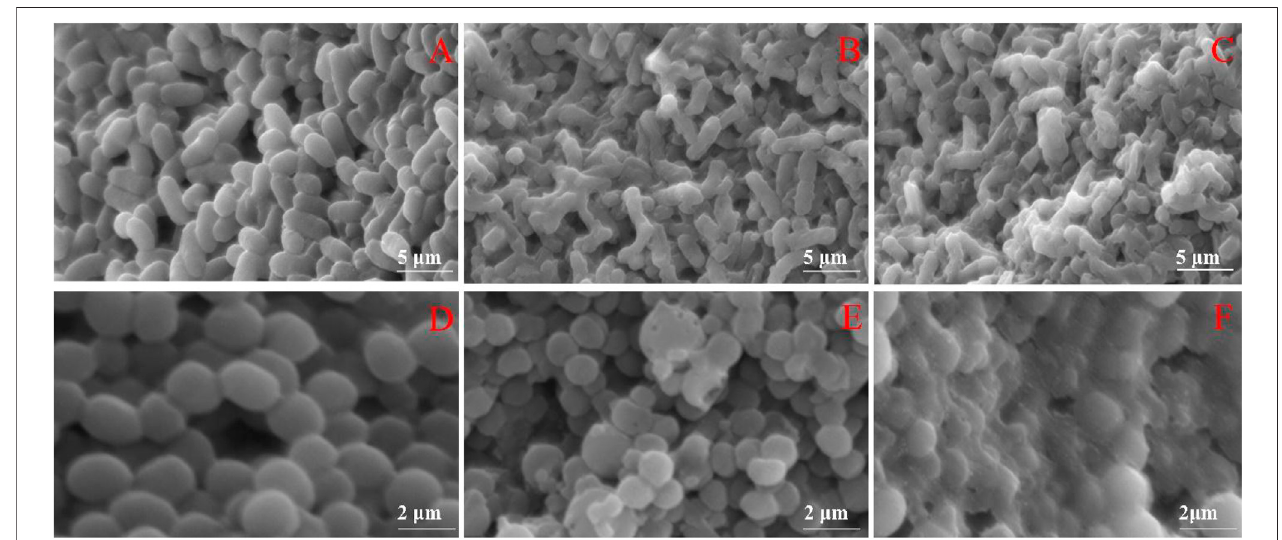
FIGURE 4 | Effects of FC on the morphology of tested bacteria (A) : Untreated E. coli . (B) : E. coli treated with MIC. (C) : E. coli treated with 2MIC. (D) : Untreated S. aureus . (E) : S. aureus treated with MIC. (F) : S. aureus treated with 2MIC).